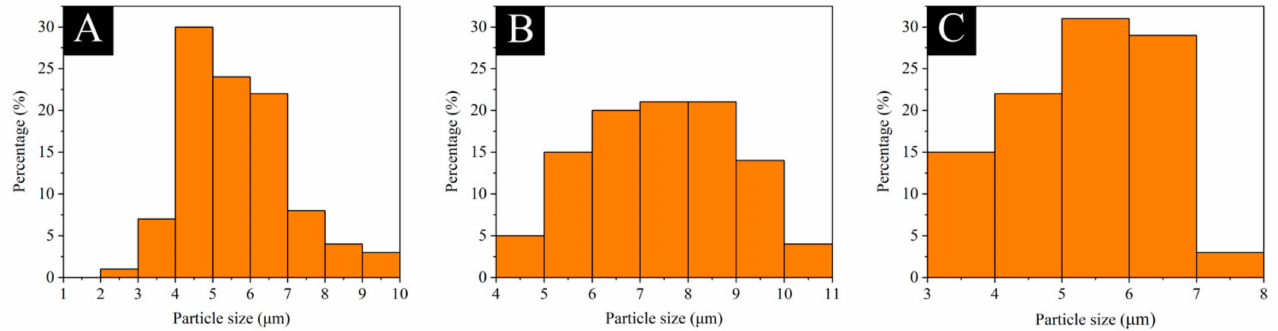
Figure 3. Particle size distribution of different shellac microcapsules: ( A ) transparent shellac micro- capsules, ( B ) purple shellac microcapsules, ( C ) yellow shellac